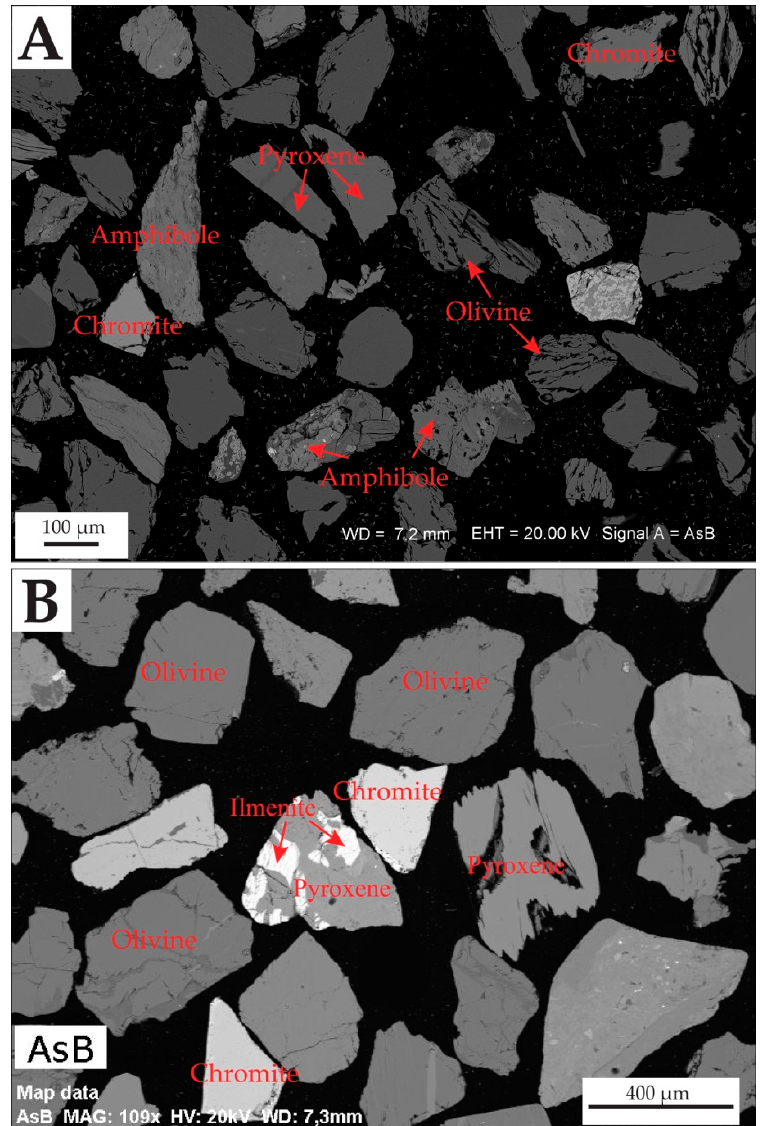
Figure 5. SEM-BSE (Scanning Electron Microscopy-Backscattered Electron Mode) images of two heavy mineral concentrates from beach sediment samples. ( A ) poorly sorted sediments, ( B ) well sorted sediments. Table 2. Analysis of grain size and degree of sorting of beach sediment samples (in %). Statistic parameters ( ϕ method [37]).